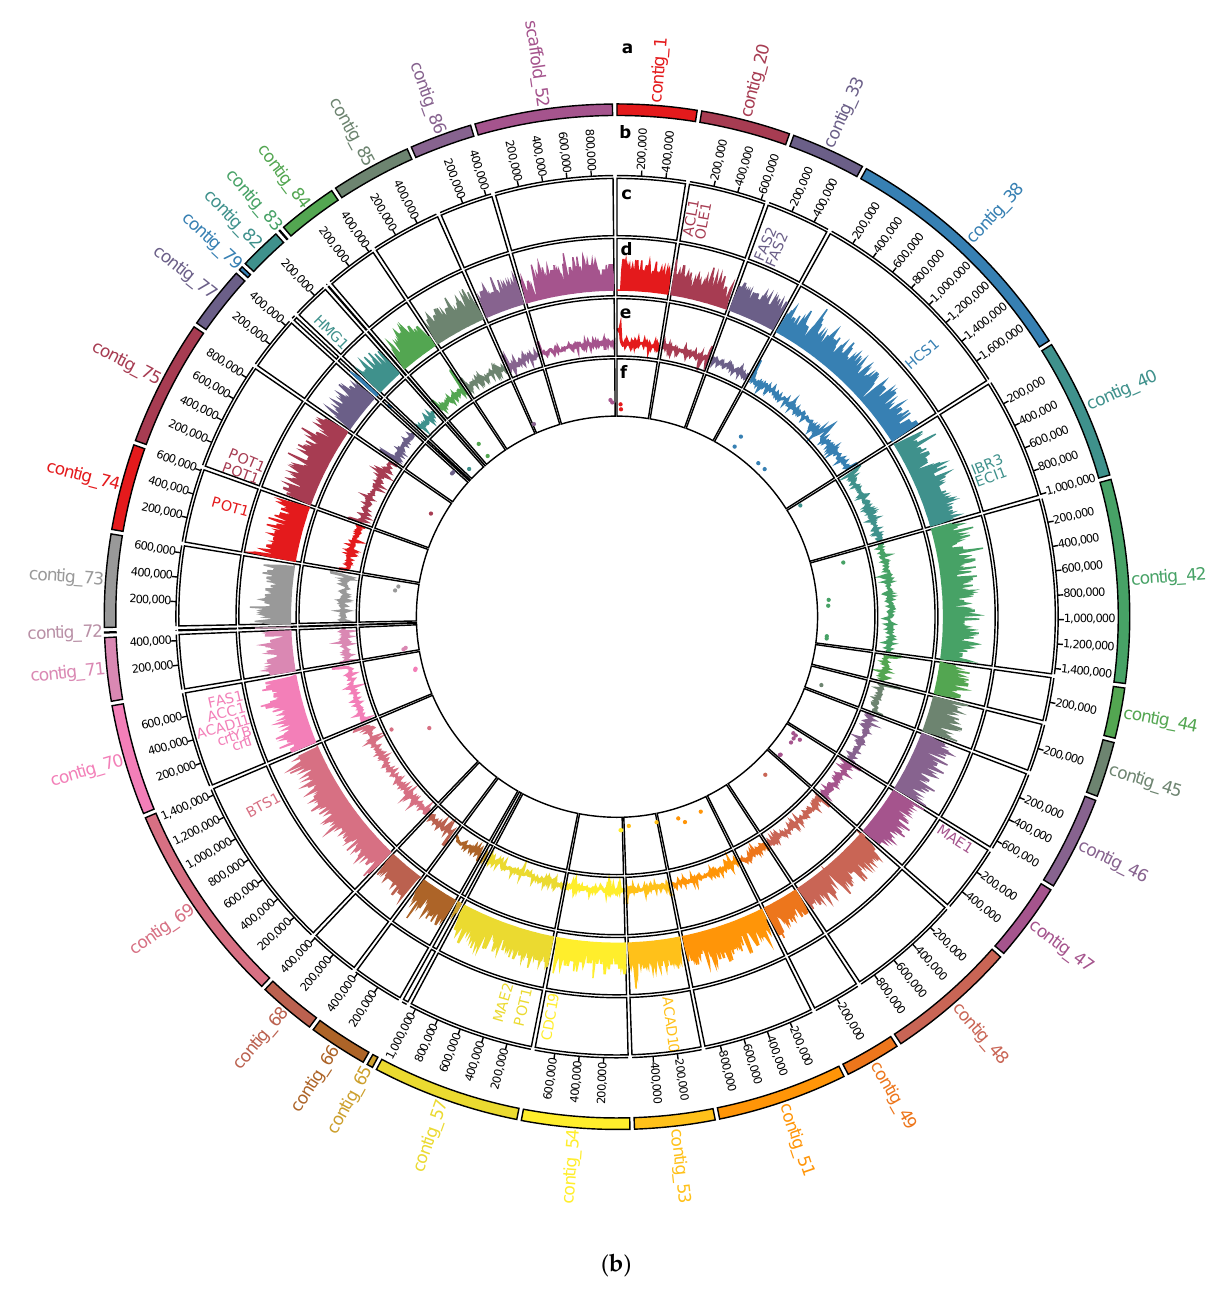
Figure 1. Overview of the genome assemblies of Rhodotorula babjevae strains: ( a ) CBS 7808, ( b ) DBVPG 8058. The concentric circles show from outside to inside: the contig name (a) and sizes (b), distribution of lipid and carotenoid metabolism related genes (c), and in non-overlapping 10 kb windows, the gene density (d), the deviation from the average GC content (e), and the density of duplicated genes with 70% sequence coverage (f).